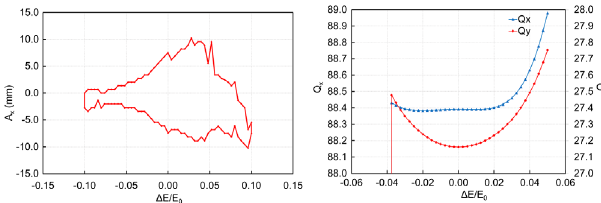
FIG. 30. Energy acceptance with Y 0 ¼ σ y (left) and bandwidth (right) of 6 GeV light